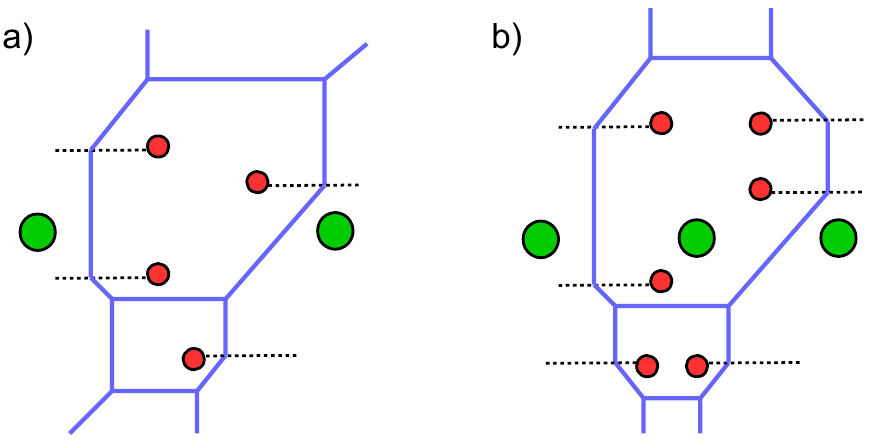
Figure 10 . Complete brane system for the dyonic loop L 1 ; 1 in the (a) SU(2) and (b) SU(3) theories.